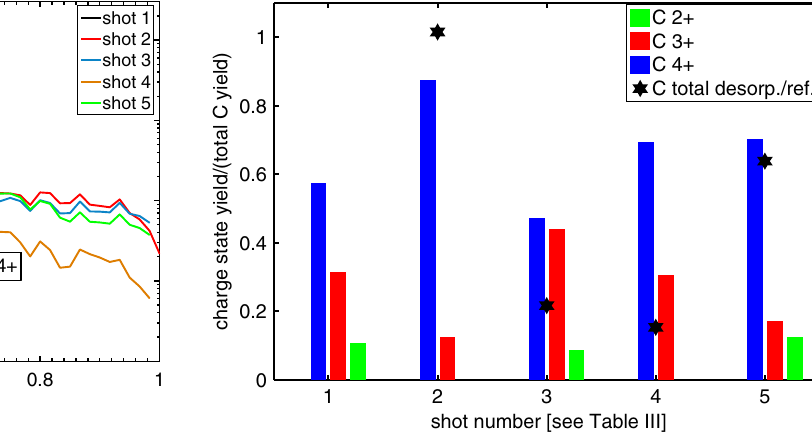
FIG. 2. Comparison of all C 4 þ (solid curves) and C 3 þ (dashed curves) spectra obtained from the discussed shots on Au foils, see Table III. While the maximum energy of C 4 þ increases when laser desorption is applied, it decreases in the case of C 3 þ compared to the reference shot (shot 1).